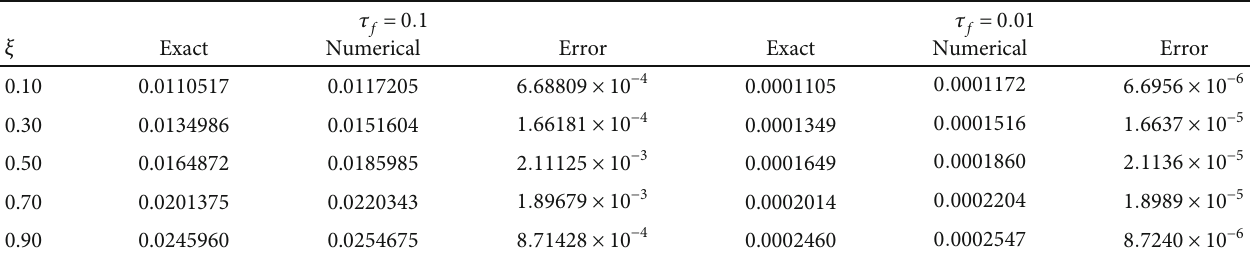
Table 3: The numerical display of the solutions for Example 1 at di ff erent values of τ